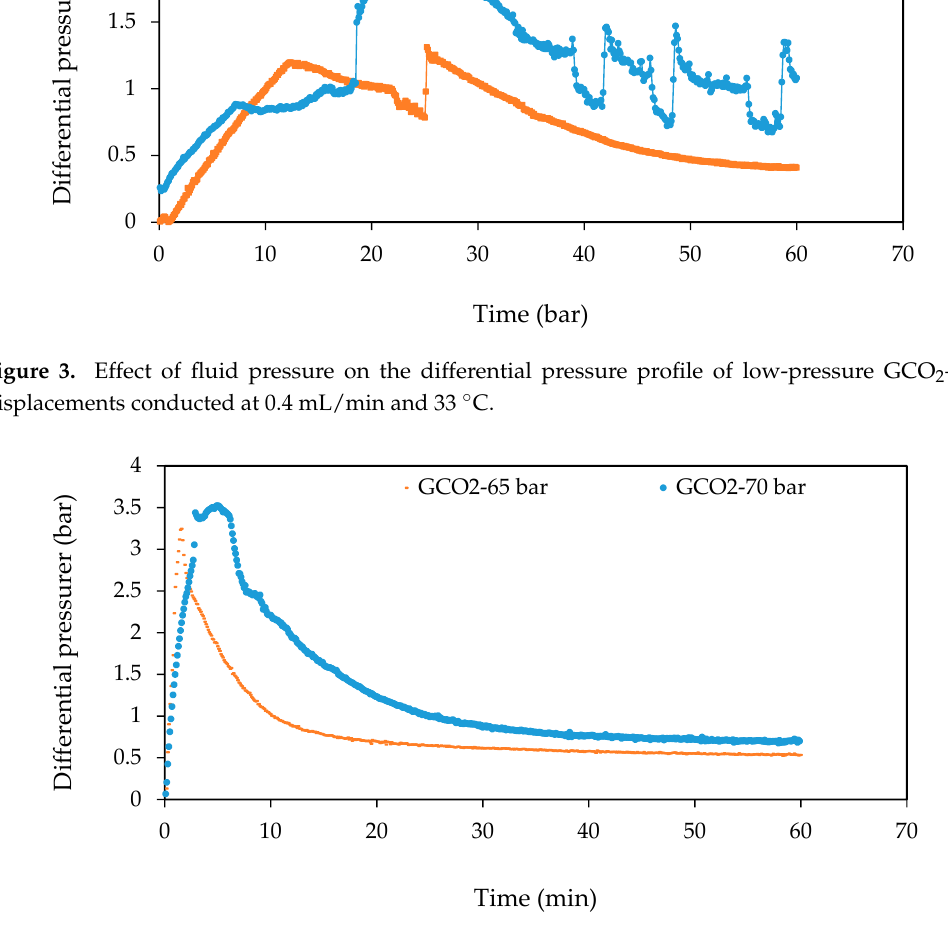
Figure 4. Effect of fluid pressure on the differential pressure profile of high-pressure GCO 2 –oil displacements conducted at 0.4 mL/min and 33 °C.